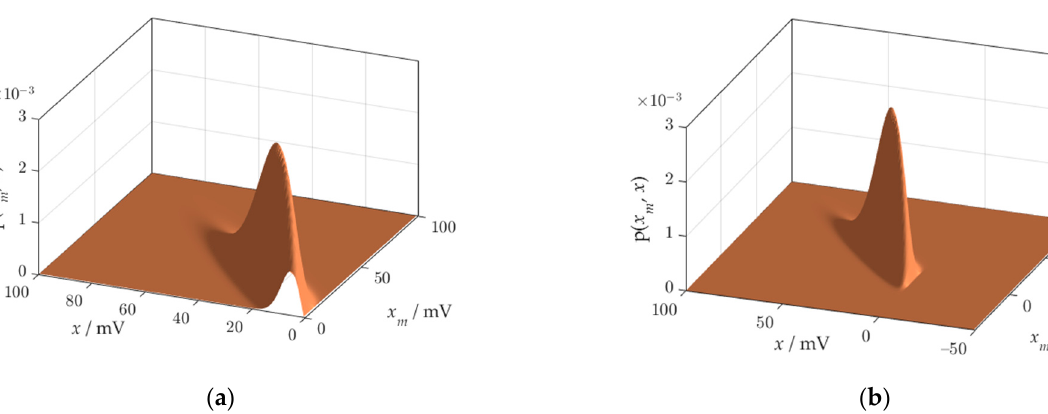
( ) Figure 8. Joint probability density function p ( x m , x ) obtained using the probabilistic model: ( a ) clipped at the zero point of , p x x obtained using the probabilistic model: ( a ) clipped at the zero point Figure 8. Joint probability density function m the domain of x m ; ( b ) reconstructed thanks to the widening the domain of x m . x ; ( b ) reconstructed thanks to the widening the domain of x . of the domain of m m